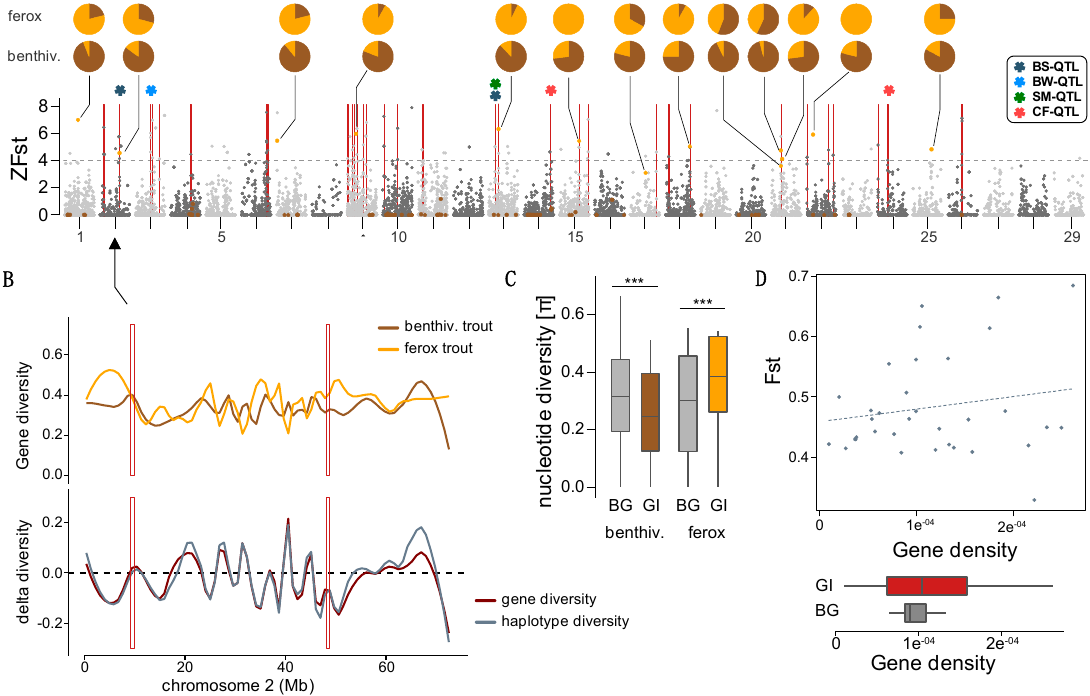
Figure 4. Genomic patterns of differentiation across the genome. ( A ) Window-based genetic differentiation (ZFst) across the Atlantic salmon genome. Note that the Atlantic salmon genome only has 29 chromosomes compared to 40 chromosomes in the brown trout genome [73]. We set negative ZFst values to zero for plotting purposes. Genomic outlier windows are highlighted with red bars. QTL derived from Atlantic salmon [96] that overlap with genomic outlier windows are highlighted by stars. BS: body shape, BW: body weight, SM: Timing of sexual maturation, CF: Condition factor. Pcadapt outlier loci associated with PC1 are highlighted in orange, and those associated with PC2 in brown. The pie charts are showing the allele frequencies of pcadapt outlier loci associated with PC1, differentiating ferox trout and benthivorous brown trout. ( B ) Patterns of haplotype-based gene diversity and delta diversity across chromosome 2. Negative delta diversity shows reduced diversity in benthivorous brown trout and vice versa. The second genomic outlier window on this chromosome shows reduced genetic diversity in benthivorous brown trout compared to ferox trout, indicative of a selective sweep in benthivorous brown trout. See Figure S3-S5 for all chromosomes. ( C ) Patterns of genetic diversity ( π ) in genomic outlier windows versus the genomic background in benthivorous brown trout and ferox trout. ( D ) Gene density is not correlated to the average degree of genetic differentiation of genomic outlier windows (Spearman’s rank correlation, r = 0.09, p = 0.618). Furthermore, gene density does not differ between genomic outlier windows and the genomic background (Wilcoxon test, p = 0.8385).